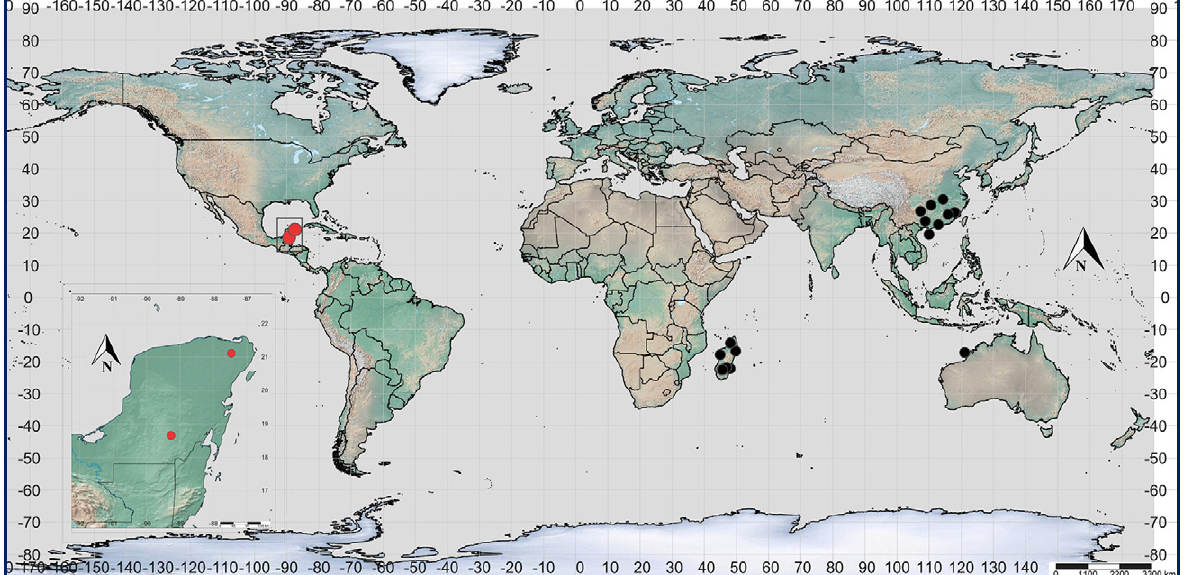
Figure 2. Distribution map of Persicaria barbata . Black circles = previously known distribution (Tropicos.org); red circles = new records in the Americas (Yucatan Peninsula,